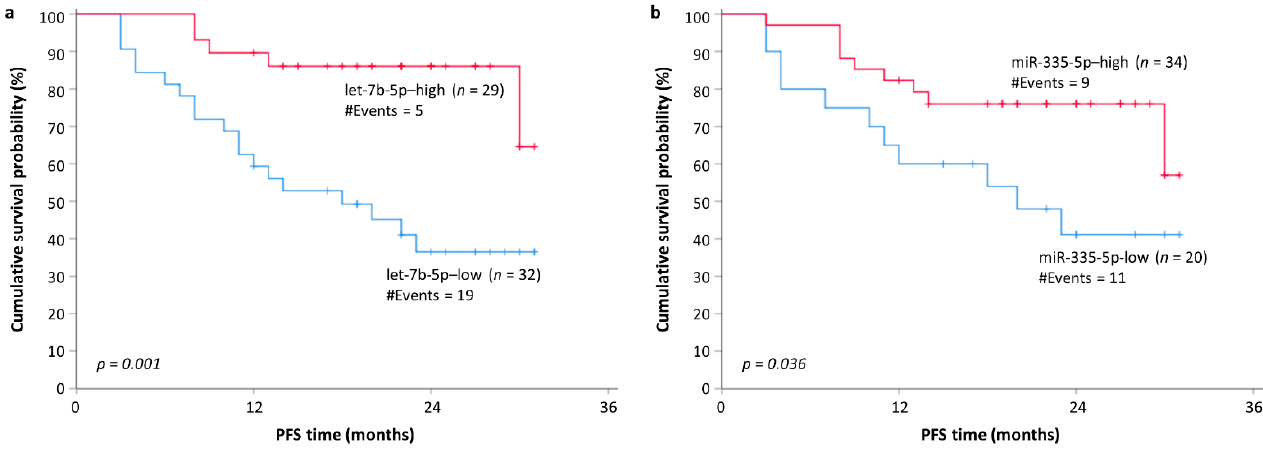
Figure 4. Kaplan–Meier survival curves for progression ‐ free survival (PFS) of MM patients. Reduced plasma levels of ( a ) let ‐ 7b ‐ 5p and ( b ) miR ‐ 335 ‐ 5p were shown as potentially unfavorable molecular markers of prognosis in MM. Table 3. Cox regression analysis regarding the prognostic potential of circulating let ‐ 7b ‐ 5p and miR ‐ 335 ‐ 5p status for the PFS of MM patients.